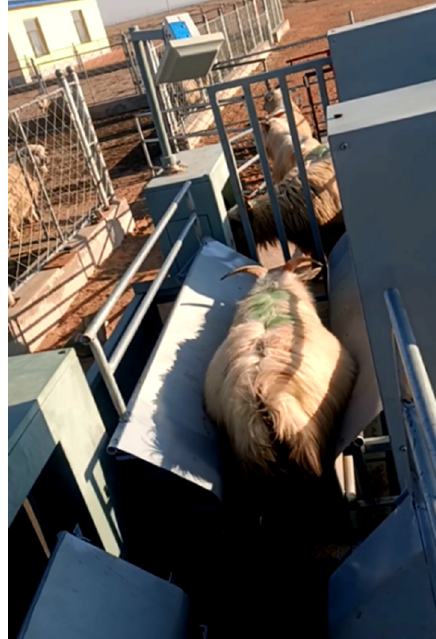
Figure 21. Site test.